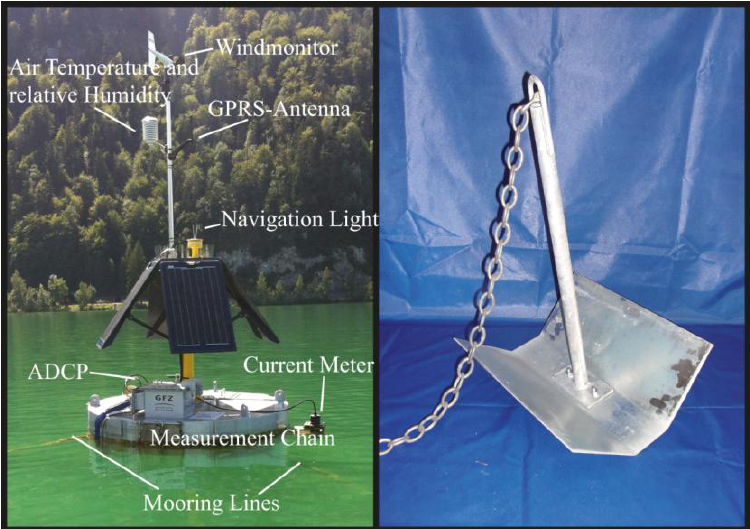
Figure 2. Buoy in operation and plate anchor as used for the